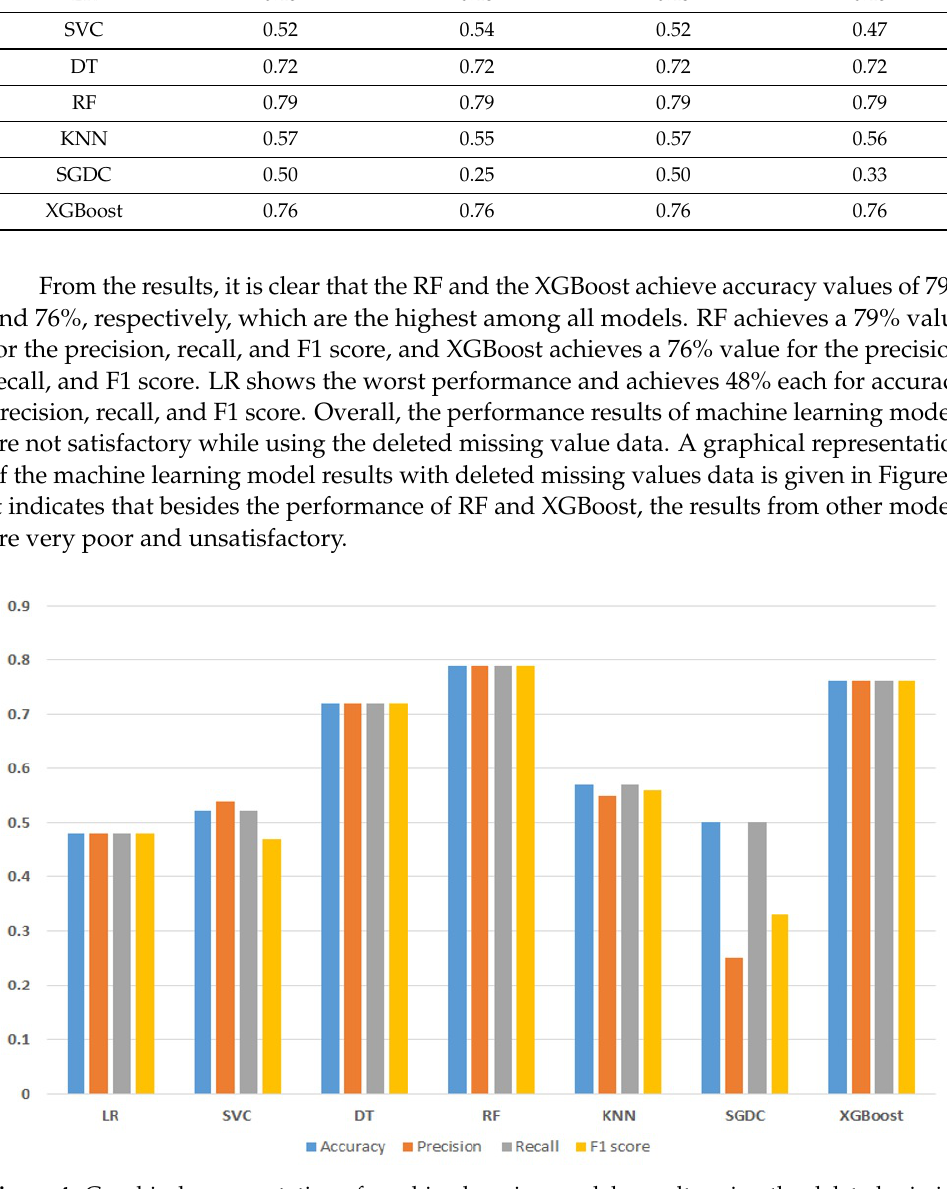
Figure 4. Graphical representation of machine learning models results using the deleted missing values